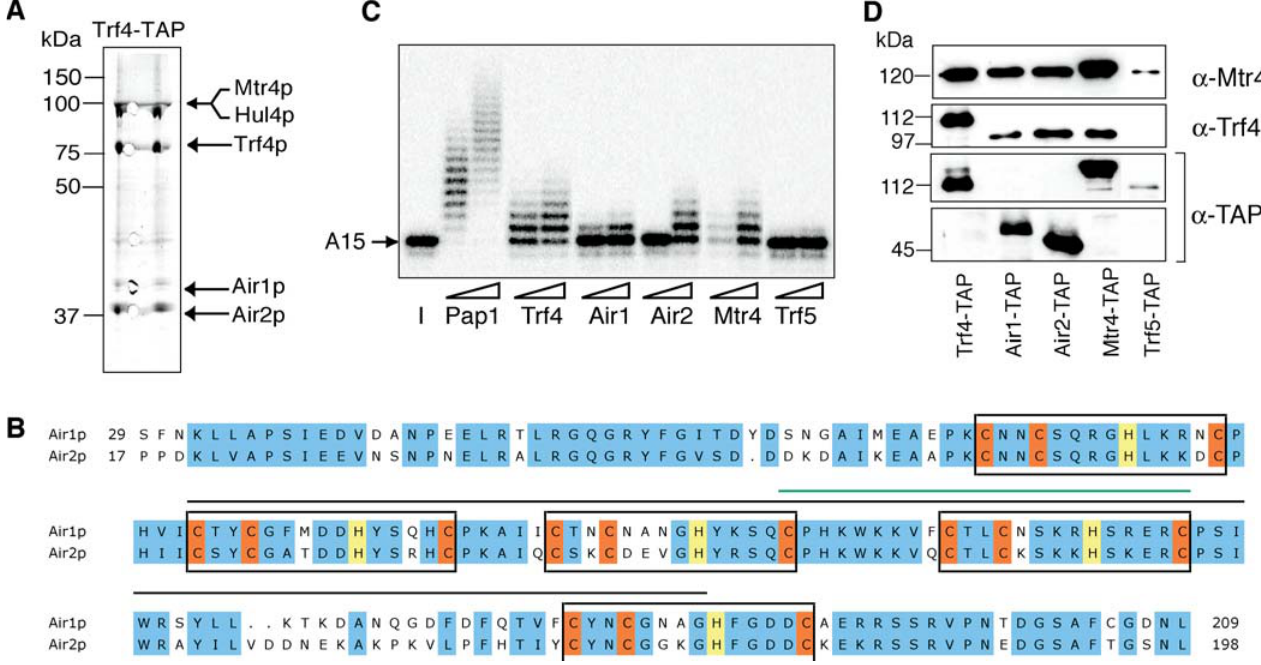
Figure 3. Characterization of the Trf4 Complex (A) Affinity purification of [His] 6 -tagged Trf4 complex identifies five associated polypeptides. Affinity-purified fractions were separated by SDS- PAGE on a 12% gel and stained with Colloidal Coomassie Blue. The protein bands indicated by arrows were identified by MS-MS sequencing. The round holes in the gel lane are a result of punching samples for MS-MS analysis. (B) Alignment of conserved regions of Air1p and Air2p. Boxes indicate five predicted CCHC-type zinc knuckle motifs. Lines above the sequences mark regions of interaction between Air1p (green) or Air2p (black) with Trf4p, as inferred from a yeast two-hybrid screen. (C) Polyadenylation activity associated with TAP-tagged versions of proteins identified as components of the Trf4 complex (Trf4, Mtr4, Air1, and Air2) and of Trf5. The 5 9 -end-labeled oligo(A 15 ) was incubated with 5 or 10 ng of the affinity-purified extracts and analyzed by electrophoresis on a 15% gel. The position of the input RNA is indicated by an arrow. Protein was omitted in lane I. Recombinant yeast poly(A) polymerase (Pap1), 5 or 15 ng, was used as a positive control. (D) Trf4p and Mtr4p copurified with TAP-tagged proteins identified in the Trf4 complex. Western blot analysis of purified eluates with anti- Trf4p and anti-Mtr4p antibody and antibody against the calmodulin-binding region in the TAP-tag ( a -TAP). The same amounts of protein complexes as used in the assay (C) were applied to the gel. The higher molecular weight of the Trf4p-TAP protein is due to the TAP-tag. All antibodies were used at a 1:2,000 dilution. DOI: